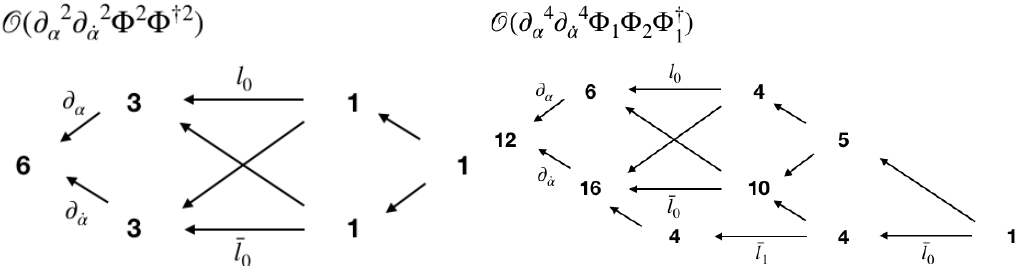
Figure 7. These two tree diagrams represent the number in each space of ∂ 2 O ( ∂ 4 ∂ 4 Φ 1 Φ 2 Φ † ) . Null spaces are not shown α ˙ α 1